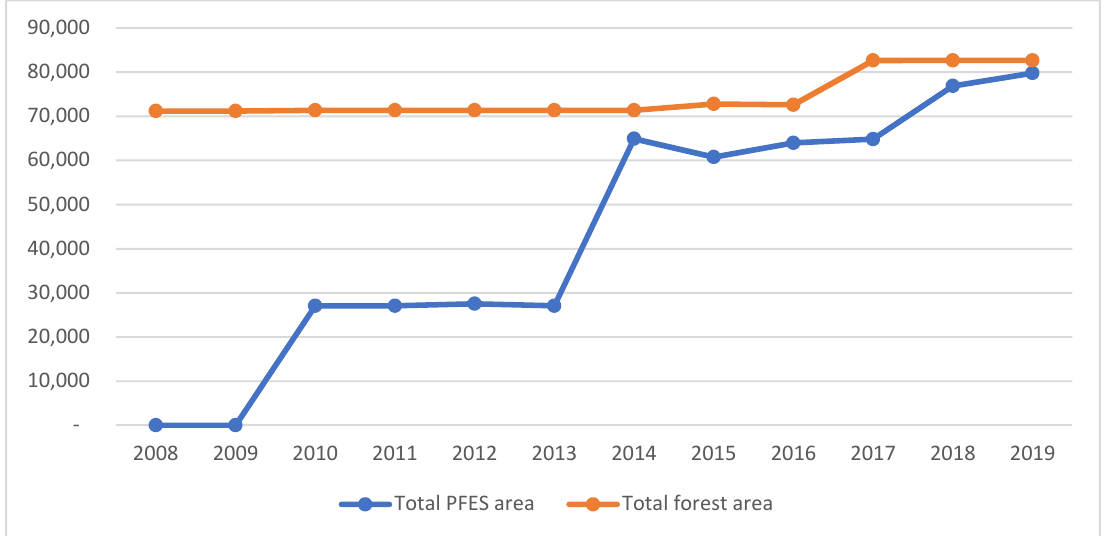
Figure 3. Total forest area in Cat Tien National Park and area allocated for PFES. Source: Cat Tien National Park 2019.